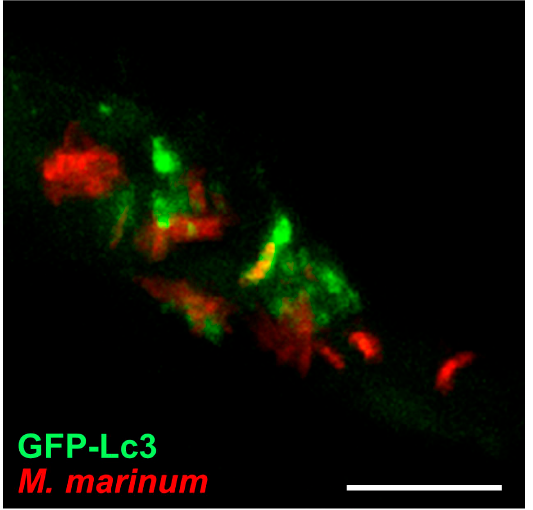
Figure 5. Confocal imaging of Tg(CMV:EGFP-Mapllc3b) on infection. GFP-Lc3 signal around clusters of M. marinum bacteria in 4-day-old zebrafish larva at 3 days post infection. Scale bars, 10 µM.